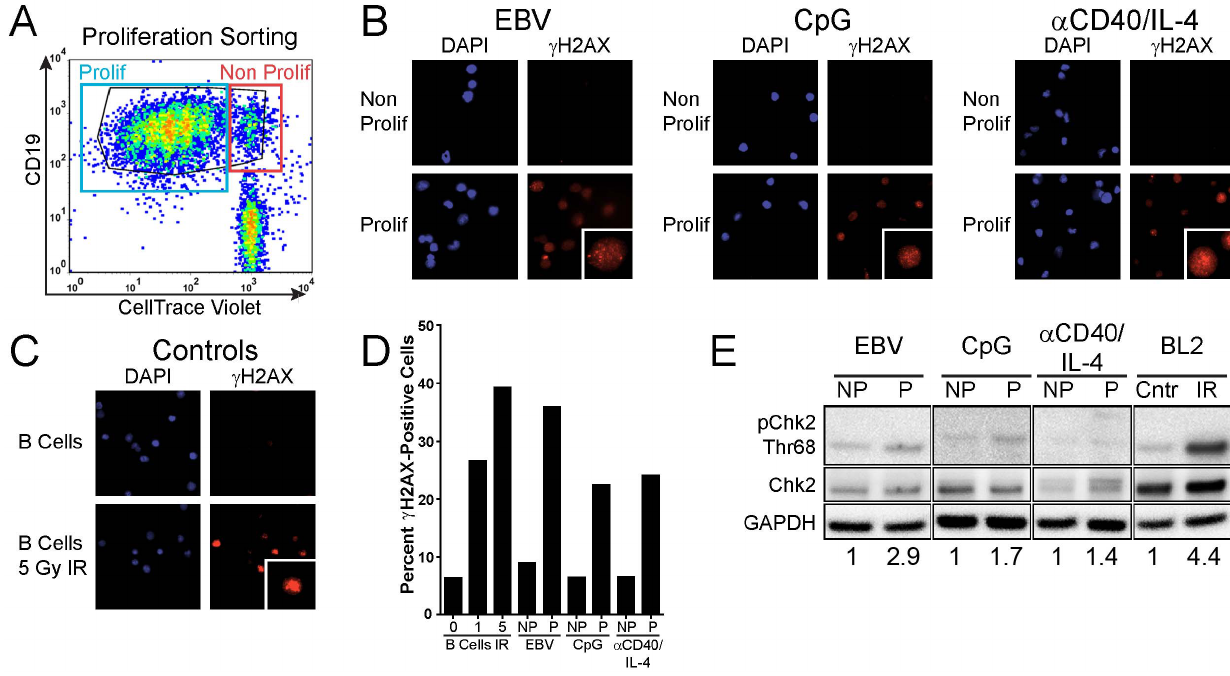
Figure 2. B-cell mitogens activate the ATM signaling pathway in proliferating cells. (A) Representative FACS plot of stimulated PBMCs showing the distribution of Cell Trace Violet stained cells versus CD19 staining for B cells. The indicated proliferating and non-proliferating populations were isolated by FACS sorting for subsequent analysis. (B) Immunofluorescence microscopy for c -H2AX (red) of sorted non-proliferating (Non Prolif) or proliferating (Prolif) B cells. The DAPI stains for DNA are shown. (C) Untreated and 5 Gy c -irradiated controls assayed as described in (B). (D) The average percentage of cells with c -H2AX intensity . 5X over background are plotted for three normal donors. Samples include B cells, untreated (0), 1 Gy, or 5 Gy c -irradiation, sorted non proliferating (NP) and proliferating (P) cells for EBV, CpG, or a CD40/IL-4 treatments. Quantification is detailed in Figure S1. (E) Western blot analysis of Chk2, Chk2 phosphorylated on Thr68 as well as the control GAPDH. Untreated (Cntr) and 5 Gy irradiated (IR) Burkitt’s lymphoma cell line 2 (BL2) are included as a positive control. Numbers indicate the normalized densitometry value for phospho-Chk2 Thr 68.